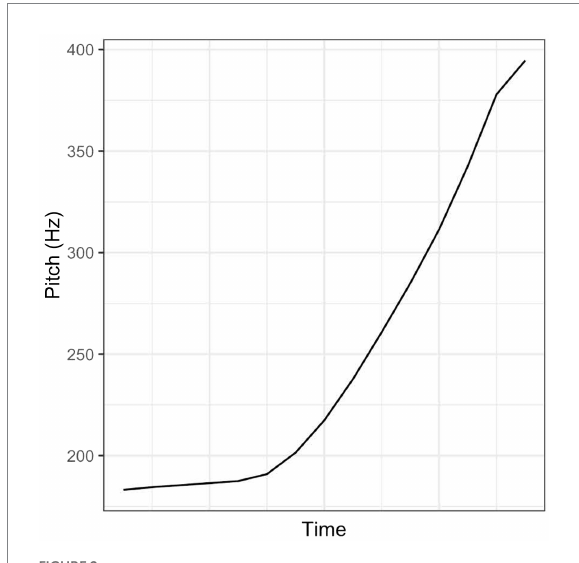
FIGURE 2 The prototype of L*H in the Dutch one-word utterance